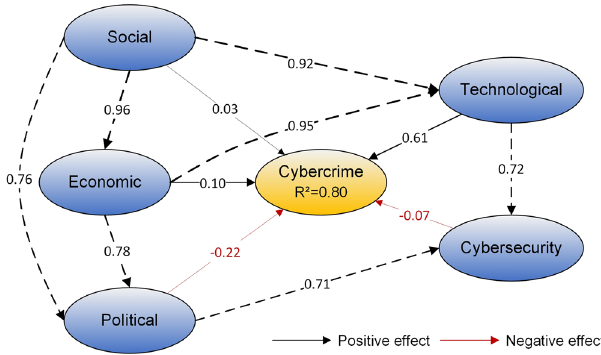
Fig. 5 SEM path diagram for the effect of the driving forces on cybercrime. Black arrows indicate a positive effect, red arrows indicate a negative effect, and values on the straight arrows between variables represent the standardised path coef fi cients.